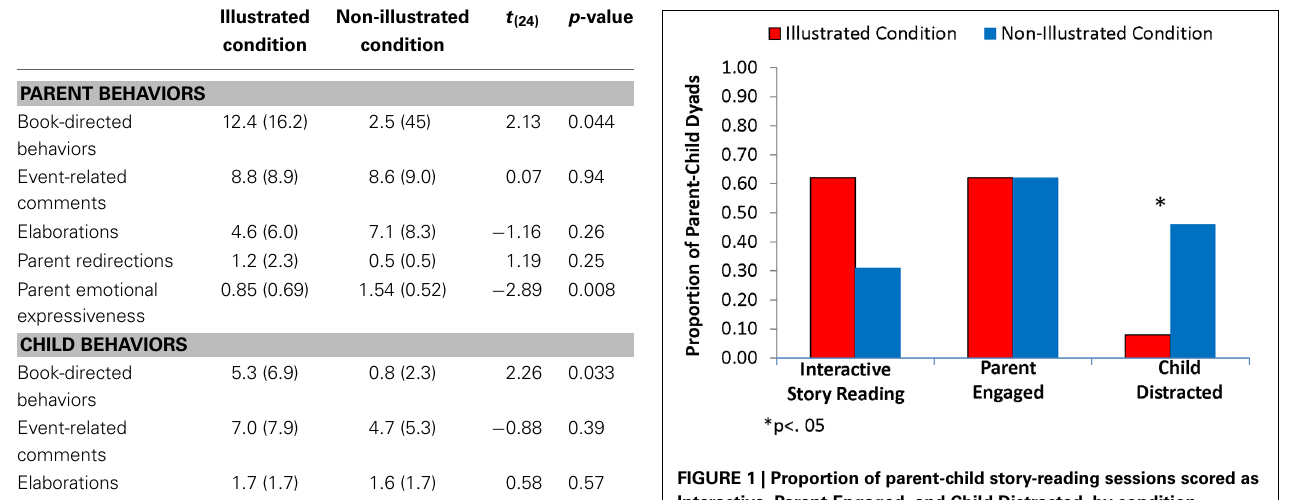
FIGURE 1 | Proportion of parent-child story-reading sessions scored as Interactive, Parent Engaged, and Child Distracted, by